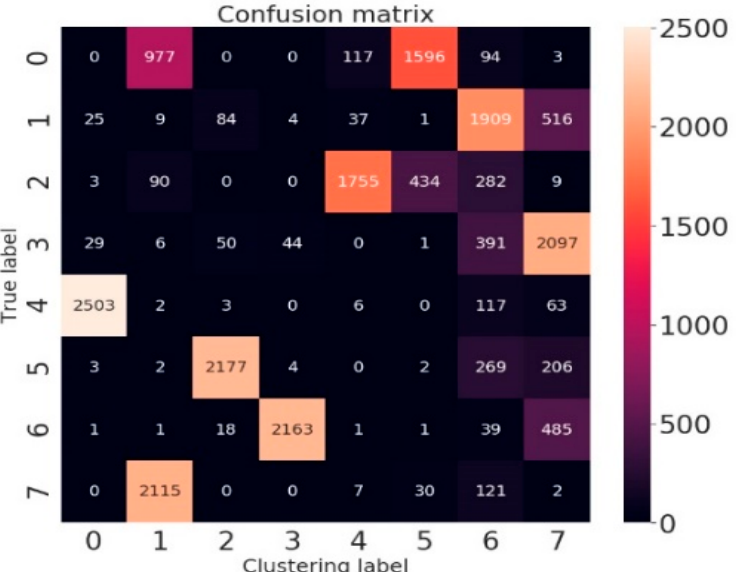
Figure 10. The Confusion Matrix illuminates the FIDC model’s performance on the Amazon-Fashion dataset.